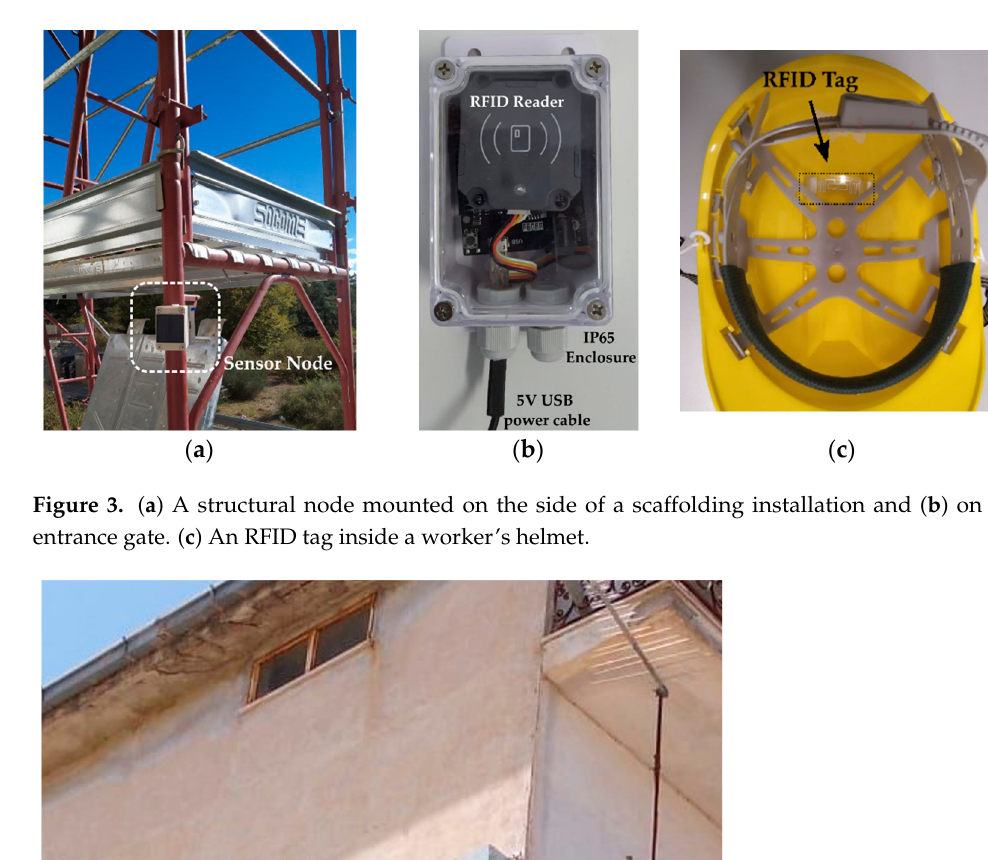
Figure 3. ( a ) A structural node mounted on the side of a scaffolding installation and ( b ) on an en- trance gate. ( c ) An RFID tag inside a worker’s helmet.